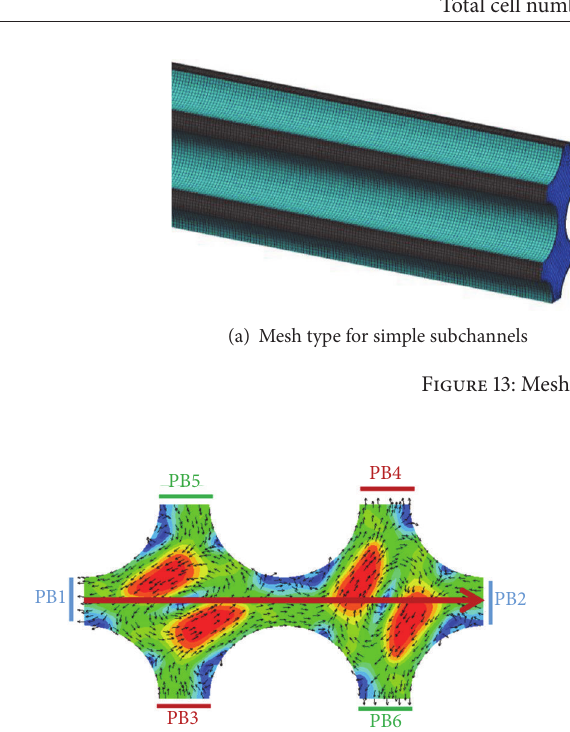
Figure 14: Boundary design and pathline for